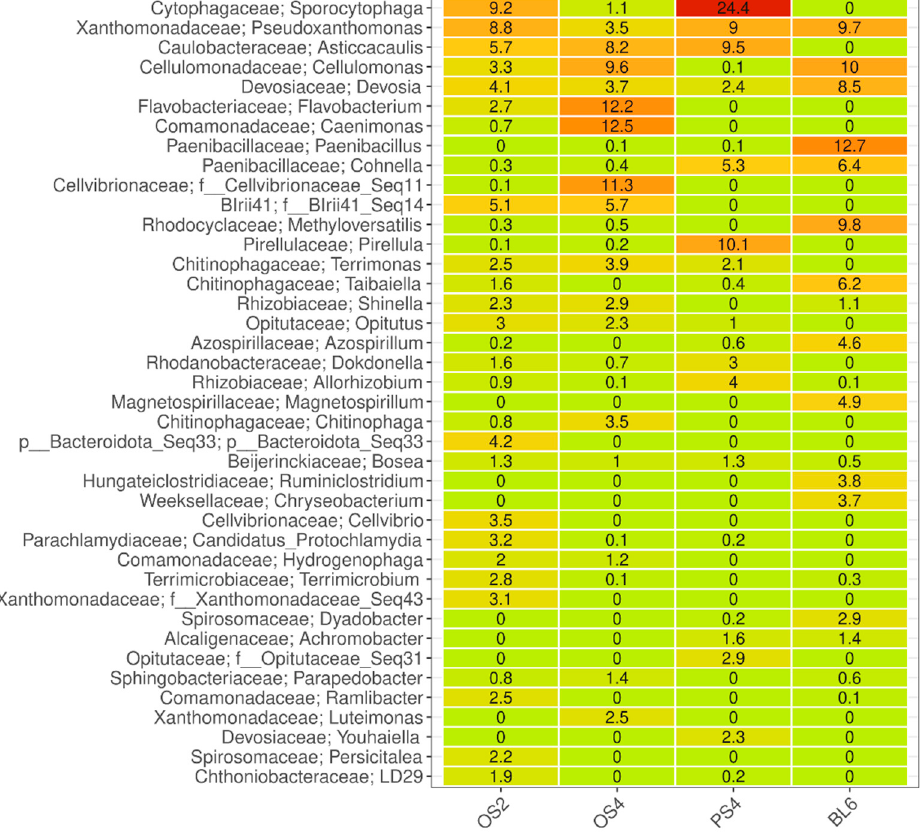
Figure 4. Heatmap of the most abundant bacterial phylotypes on the genus level in the four cel- lulolytic consortia (OS2, OS4, PS4, BL6). Relative abundance given in % of the read count of each consortium, red for maximal, and green for minimal values.